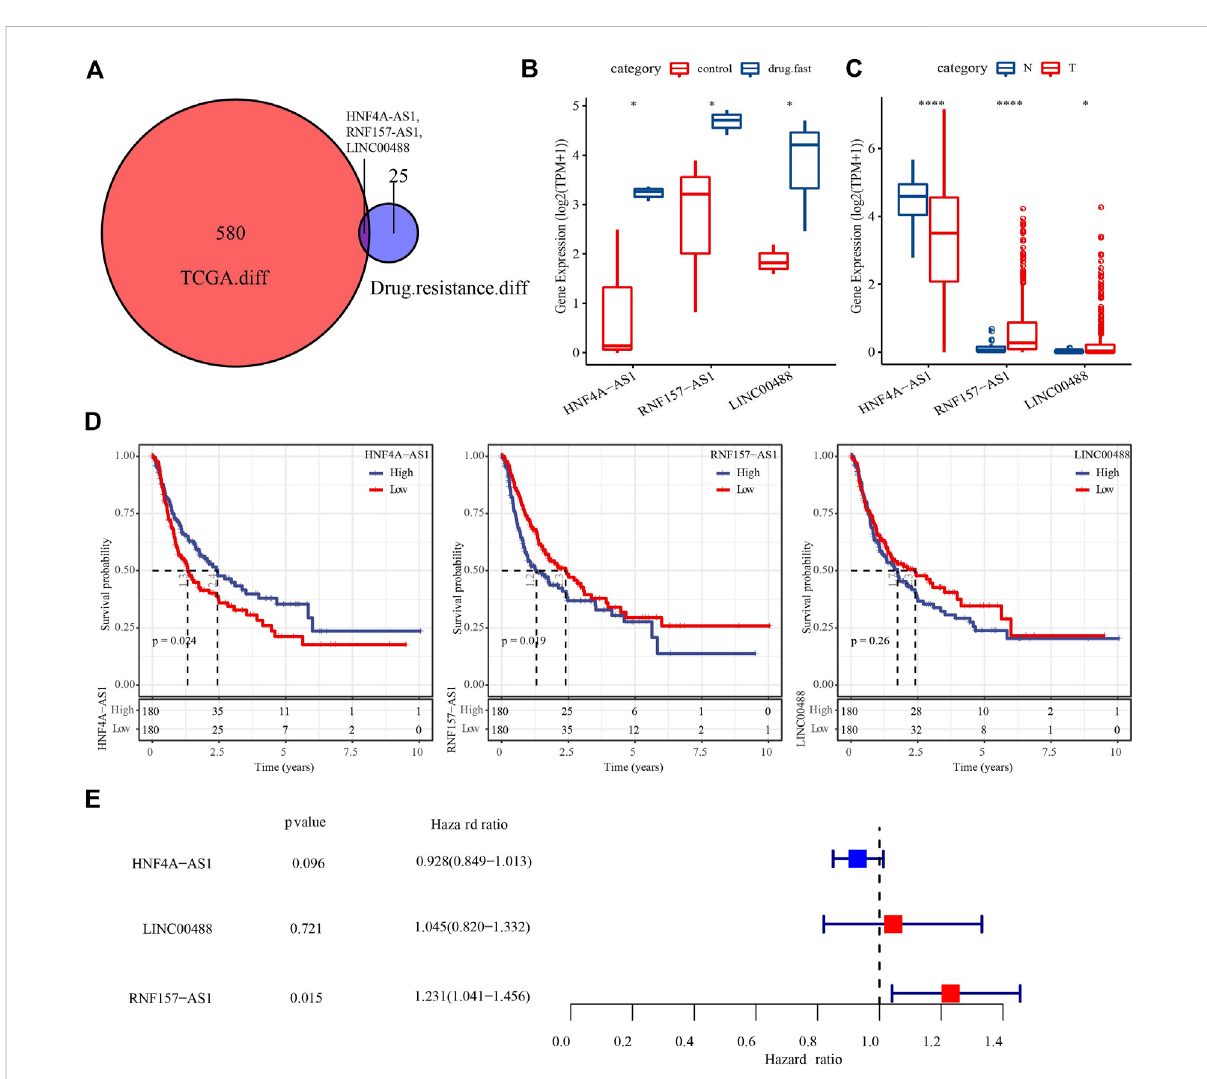
FIGURE 1 Identi fi cation of key DElncRNAs related to drug resistance and HCC prognosis. (A) Venn plot of DElncRNAs in the TCGA and GSE125180 datasets. (B) Expression of three DElncRNAs in control and drug-fast samples from the GSE125180 dataset. Wilcoxon tests were conducted. (C) Expression of three DElncRNAs in HCC and paracancerous samples in the TCGA dataset. Wilcoxon tests were conducted. (D) Kaplan – Meier survival plots of high- and low-expression of three DElncRNAs. (E) Univariate Cox regression analysis of three DElncRNAs. Log- rank tests were conducted. * p < 0.05, **** p <